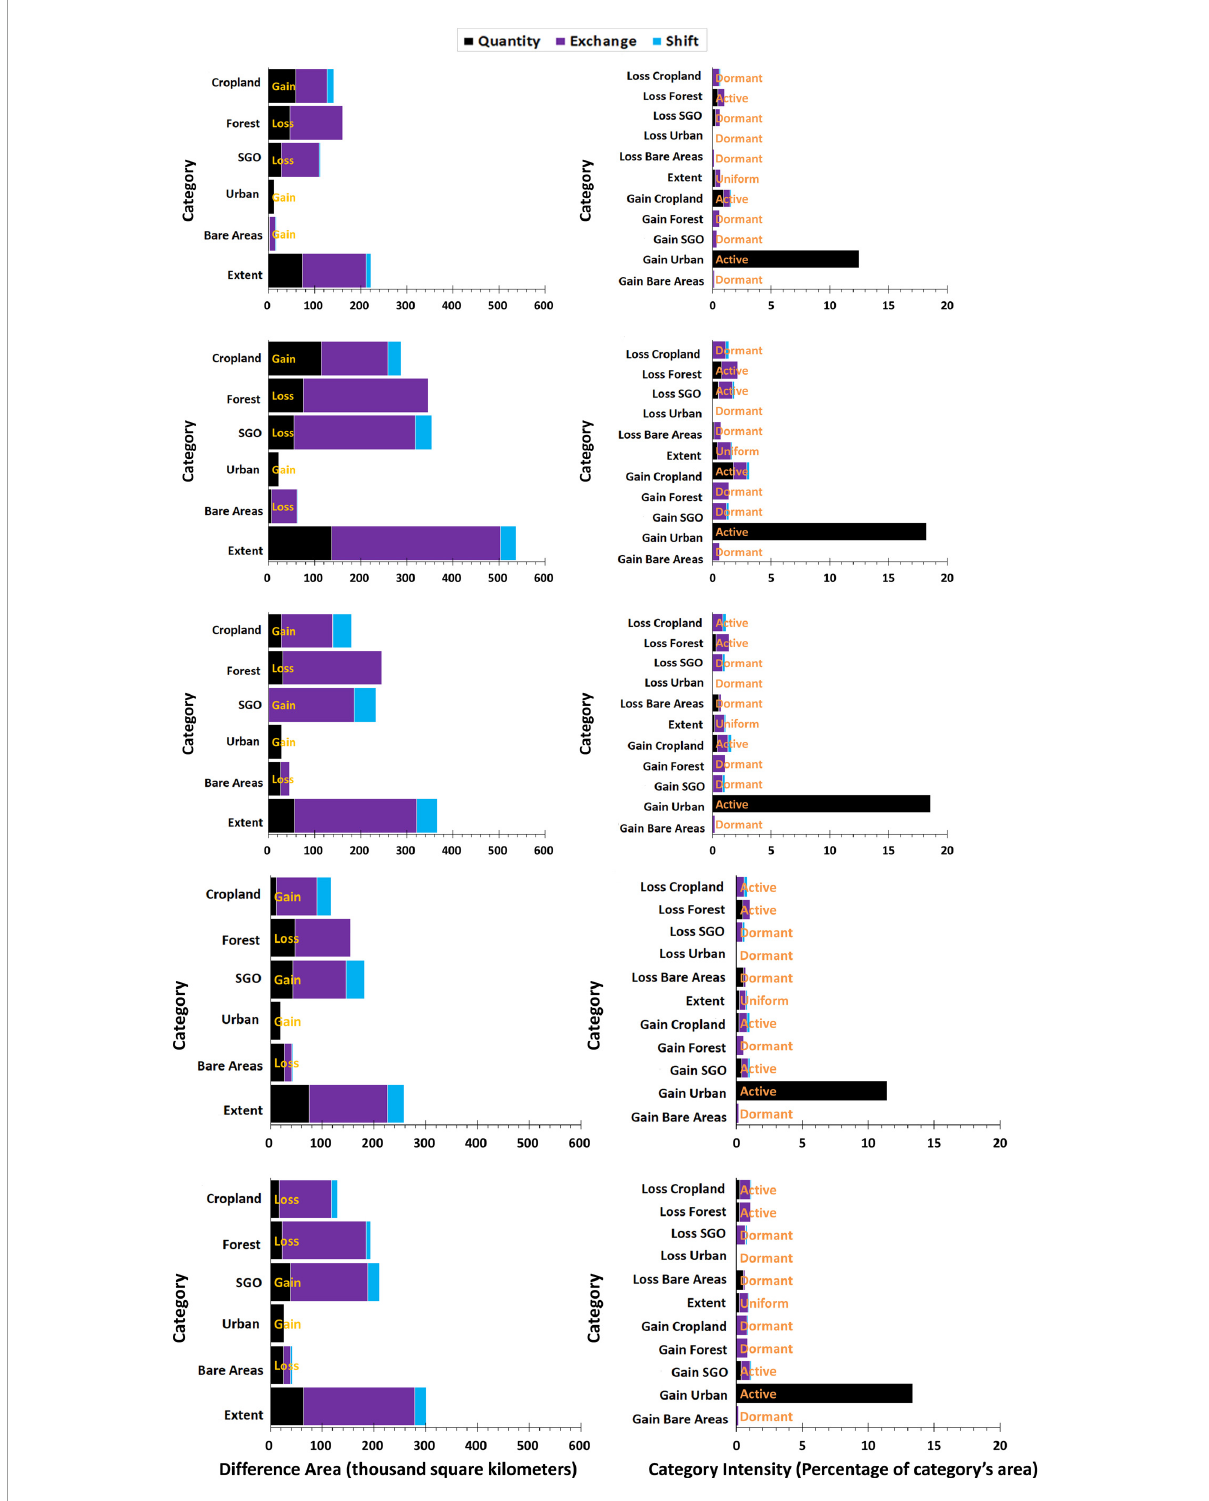
FIGURE2 The categorical level losses and gains in terms of the difference areas (left-hand side) and intensities (right-hand side) during the time intervals 1992–1997, 1997–2002, 2002–2007 and 2007–2012, 2012–2018. The intensities for each category are divided into the three components of change: Quantity (black), Exchange (purple), and Shift